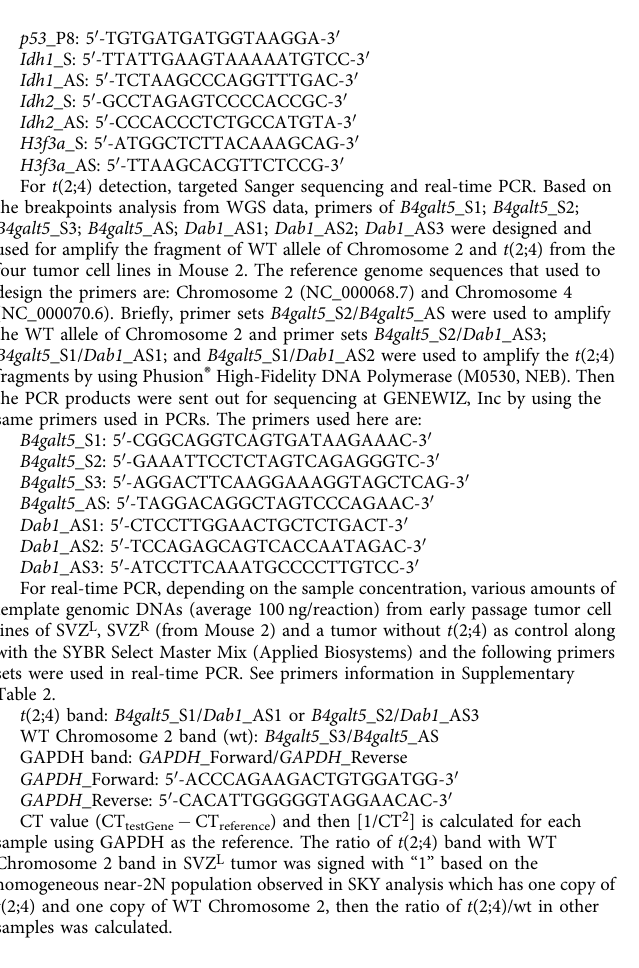
Fig. 8 Rictor/mTORC2 loss inhibits distant dispersal. a – e p53 Δ E5 – 6 CKO ( n = 14) and p53 Δ E5 – 6 Rictor Δ / Δ CKO ( n = 9) mice at age of 5 – 7 months were injected with BrdU to detect proliferating cells in tumor-free brains. Adjacent brain sections were stained for BrdU ( a , b ), co-labeled for p53 and Olig2 ( c ), or co-labeled for BrdU and p53 ( d ). a , c A representative image with BrdU + proliferating clusters identi fi ed in multiple regions from p53 Δ E5 – 6 CKO mice (5 out of 14) was shown in ( a ). All the three clusters containing early glioma-like cells comprised of Olig2 + p53 Δ E5 – 6 cells (indicated by arrows) ( c ). b , d A representative image with BrdU + proliferating cells located in SVZ-associated areas from p53 Δ E5 – 6 Rictor Δ / Δ CKO mice (eight out of nine) was shown in ( b ). BrdU + cells with p53 Δ E5 – 6 expression (indicated with arrows) were identi fi ed in the SVZ-associated areas in p53 Δ E5 – 6 Rictor Δ / Δ CKO brain ( d ). e The number of brains with early tumor cluster(s) characterized by BrdU + Olig2 + cells was compared in 5 – 7-month-old p53 Δ E5 – 6 CKO and p53 Δ E5 – 6 Rictor Δ / Δ CKO models. Fisher ’ s exact test was used to analyze the statistical difference. * p <0.05. H&E staining shows representative brains with multifocal lesions and single lesion from the p53 Δ E5 – 6 CKO ( f ) and p53 Δ E5 – 6 Rictor Δ / Δ CKO ( g ) mice at end stages, respectively. Analysis of brain histology demonstrated the percentage of brains with multifocal tumors ( h ) and brains with tumors directly associated with the SVZ only ( i ). Analysis was compared among three p53 CKO models, p53 Δ E5 – 6 Rictor Δ / + CKO and p53 Δ E5 – 6 Rictor Δ / Δ CKO models. Fisher ’ s exact test was used to analyze the statistical difference. ** p <0.01, *** p <0.001, **** p < 0.0001. j Model of a single-cell-derived early tumor cluster that sequentially accumulates GBM-relevant driver alterations in the RAS/MAPK and PI3K/AK/ mTORC pathways, driving local expansion and distant dispersal during GBM evolution. SVZ subventricular zone, LV lateral ventricle, RMS rostral migratory stream. Scale bars: 50 µ m ( c , d ); 1mm ( a , b , f , g